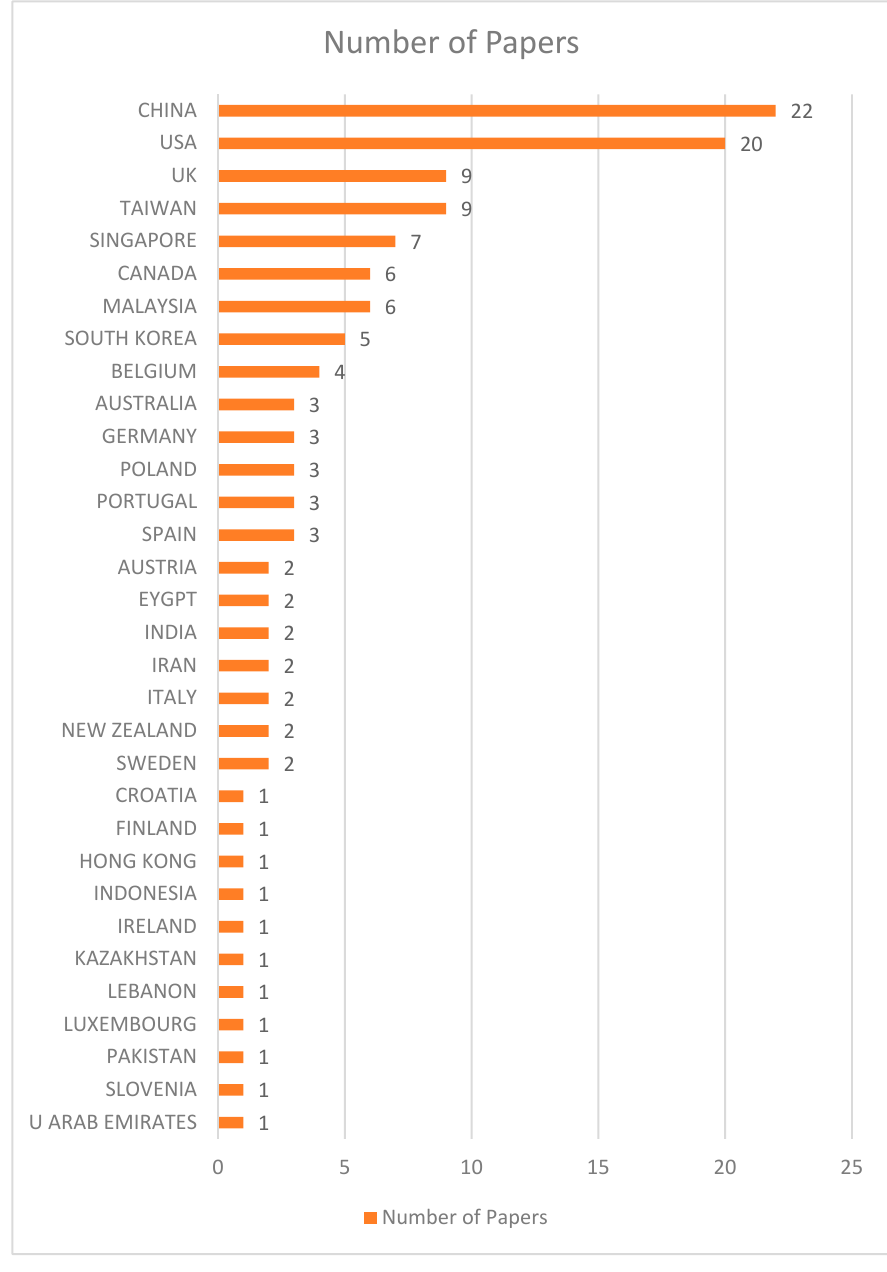
Figure 3. Number of publications per country or region (the country/region of first